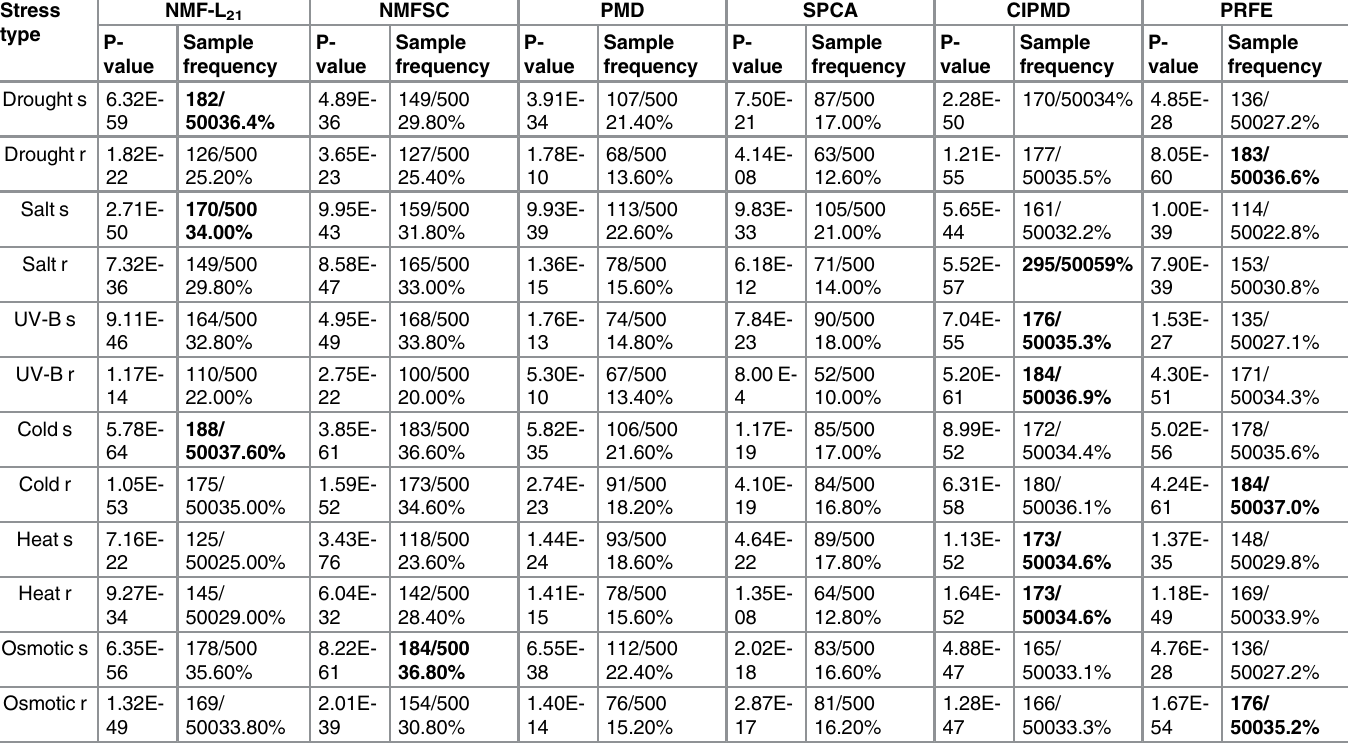
Table 4. Response to an Abiotic Stimulus